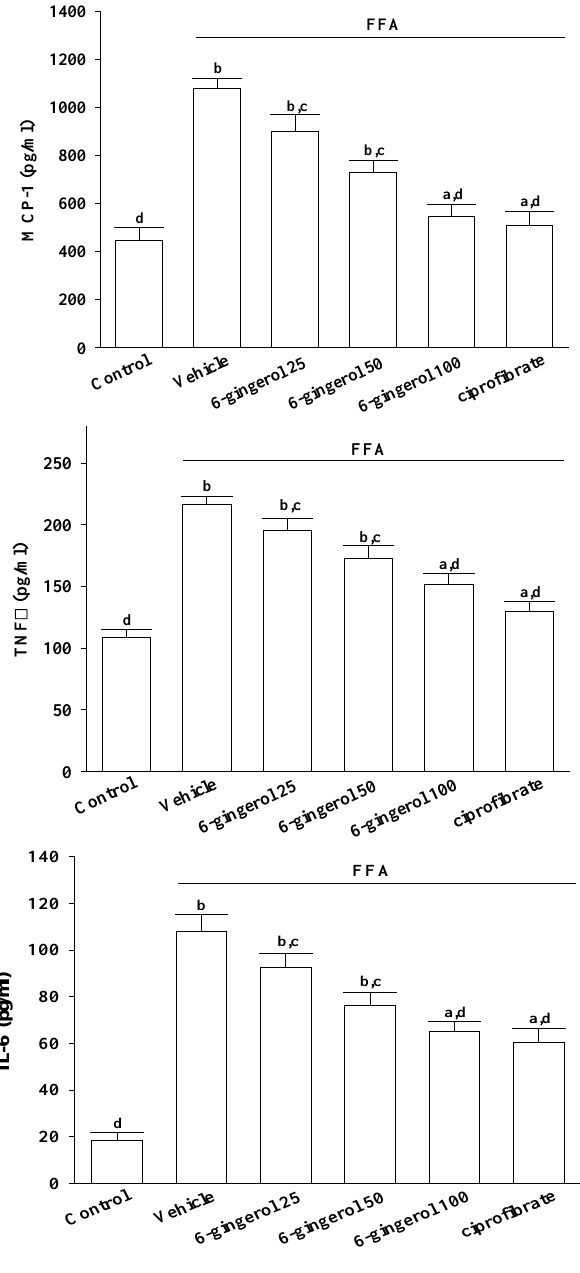
Figure 3. Different treatment effects on FFAs mixture-induced inflammatory cytokines overproduction in HepG2 cells. HepG2 cells were exposed to a FFAs mixture (0.33 mmol/L palmitate and 0.66 mmol/L oleate) for 24 h only or pre-incubated with 6-gingerol at concentrations of 25 μmol/L (6-gingerol 25), 50 μmol/L (6-gingerol 50), or 100 μmol/L (6-gingerol 100), or with 100 μmol/L of ciprofibrate (ciprofibrate). The vehicle (distilled water) used to prepare the test medication solutions was given at the same volume. MCP-1, TNF-α, and IL-6 concentrations in cell-free culture supernatants were determined by ELISA. Cells supplemented with medium without any treatment served as the control. The results are the means ± SD of eight experiments. a p < 0.05 and b p < 0.01 compared to the untreated control results. c p < 0.05 and d p < 0.01 compared to the results for FFAs mixture-treated